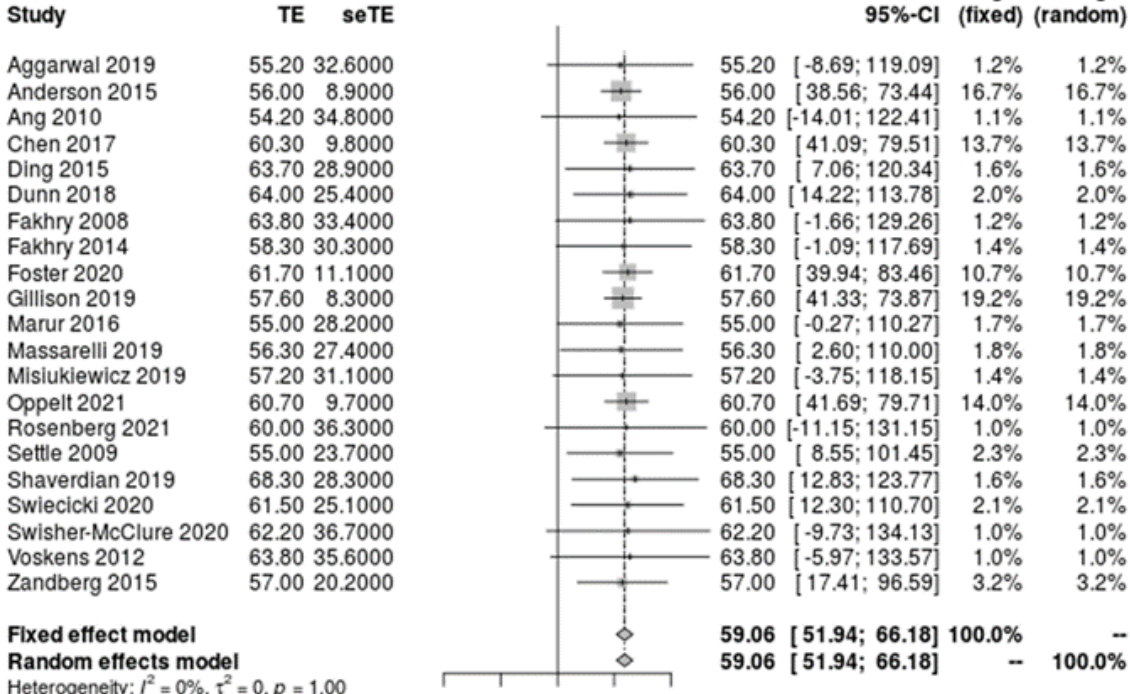
Cancers 2022 , 14 , 4061 Figure 2. Meta-analysis of single means for participant age. Figure 2. Meta-analysis of single means for participant age.